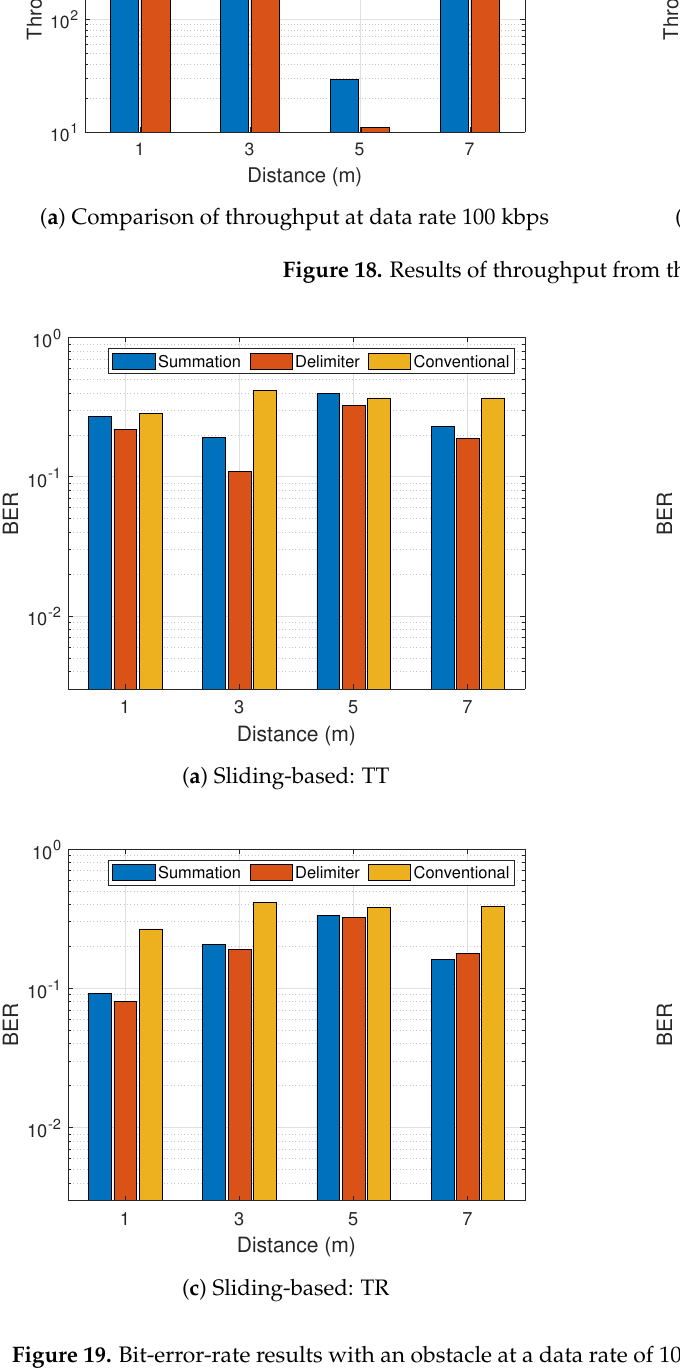
Figure 19. Bit-error-rate results with an obstacle at a data rate of 100 kbps (TT: obstacle between transmitter and tag, TR: obstacle between tag and